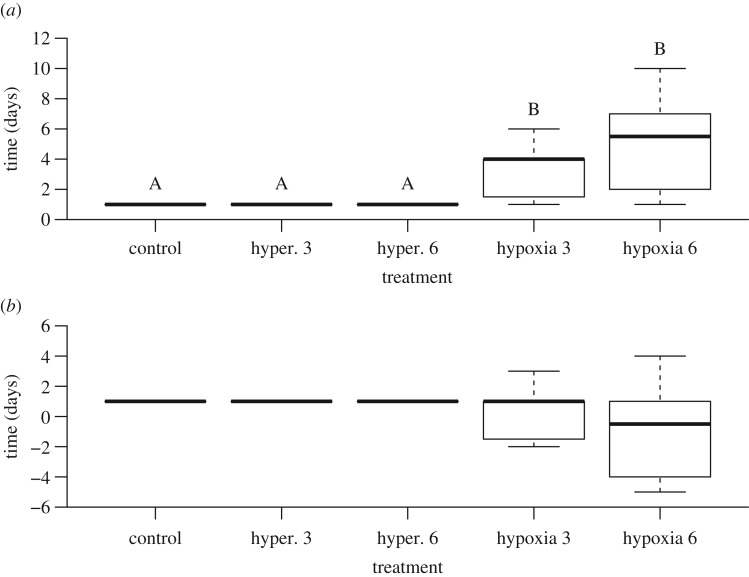
Latency from oviposition to formation of the white spot on saltwater crocodile eggs in (a) total time and (b) aerobic time. Eggs (N = 73) were incubated in either normoxia (control), hyperoxia (42% O2) for 3 (hyper. 3) or 6 (hyper. 6) days, or hypoxia (1% O2) for 3 (hypoxia 3) or 6 days (hypoxia 6) (n = 14–15). Aerobic time is the total time from oviposition excluding time spent in hypoxia. Boxplot centre lines show medians; box limits indicate the 25th and 75th percentiles; whiskers extend 1.5 times the interquartile range from the 25th and 75th percentiles. For (a) if the letters above each whisker are the same, latency to white spot formation did not differ significantly between corresponding treatment-groups (Kruskal–Wallis and Nemenyi's post hoc test; p < 0.0001). For (b) there was no significant between-group difference (Kruskal–Wallis and Nemenyi's post hoc test; p > 0.05).